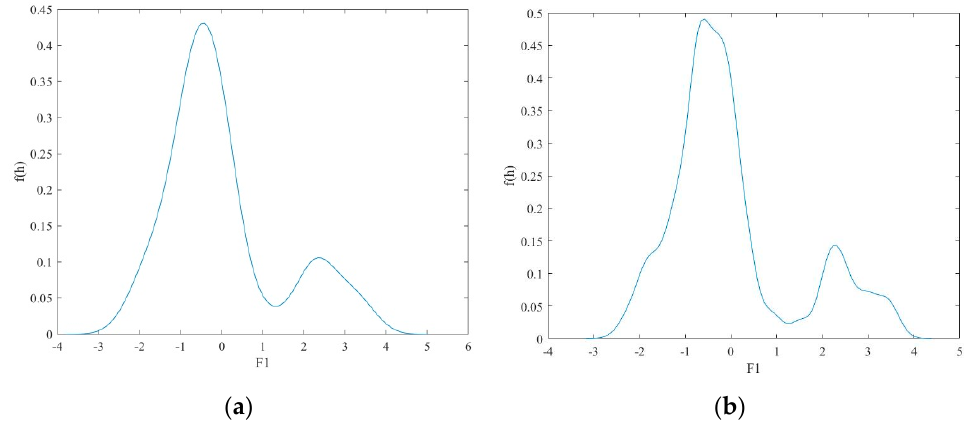
Figure 6. Kernel density estimation curves of different bandwidths, the band width in ( a ) is 0.4, and the bandwidth in ( b ) is the value calculated according to Equation (10).